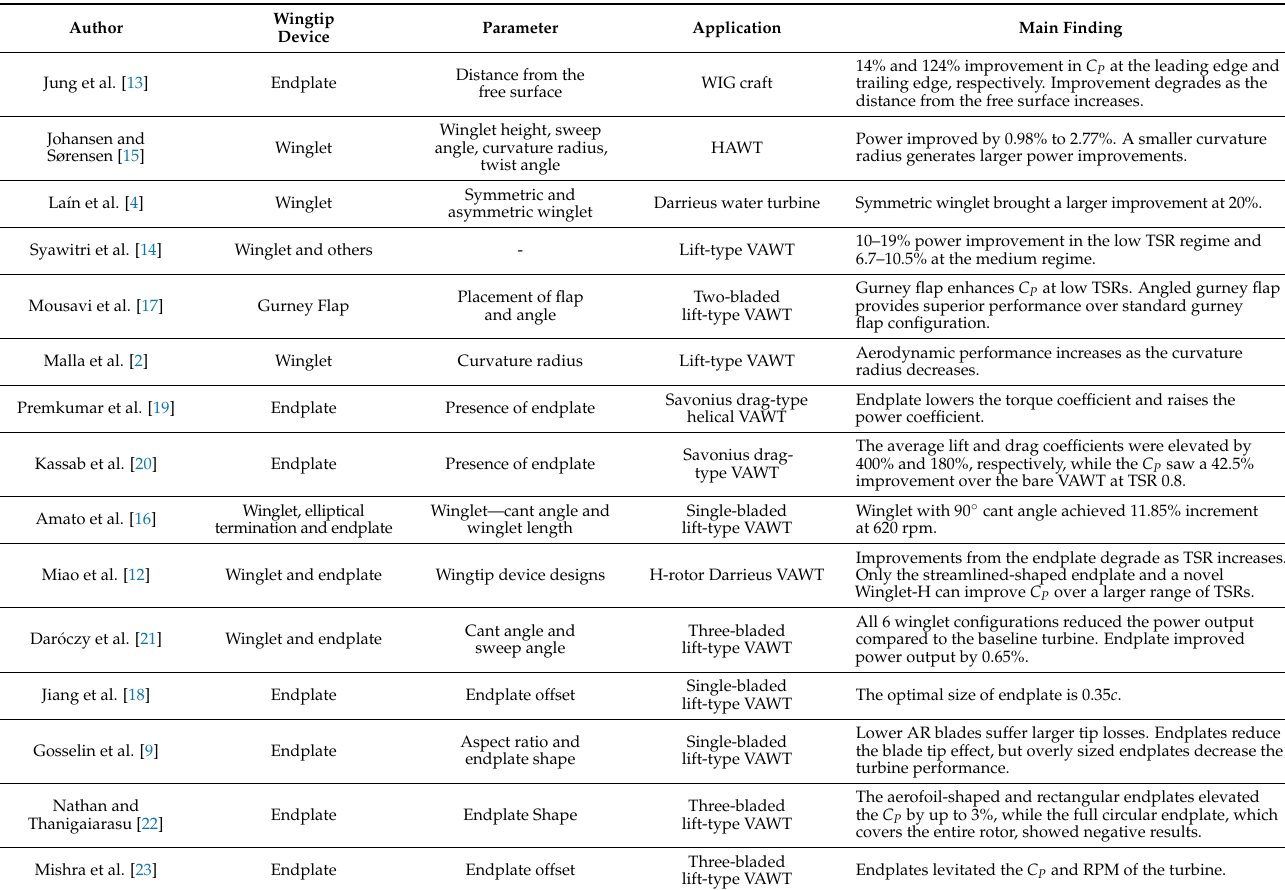
Table 1. A summary of wingtip devices from the literature